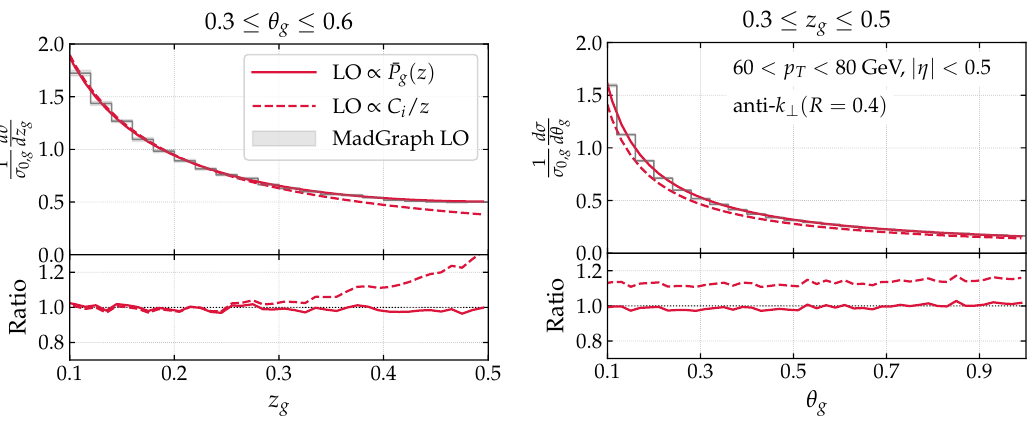
Figure 3 . Left: z g differential distribution at leading order in α s for the gluon channel in a bin of θ g computed in three different ways: with MadGraph (gray), using the splitting function as a proxy for the leading order result, see eq. (2.70), either with the leading order expression of P i ( z ) (solid, red) or taking the soft limit (dashed, red). Right: same as left panel but for θ g